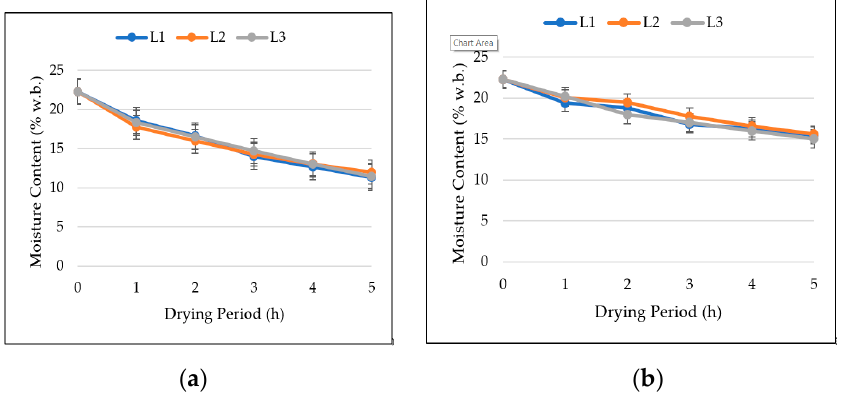
Figure 9. Variation of moisture contents at L1, L2, and L3 at the ( a ) inner section of the drying chamber; and ( b ) outer sections of the drying chamber.